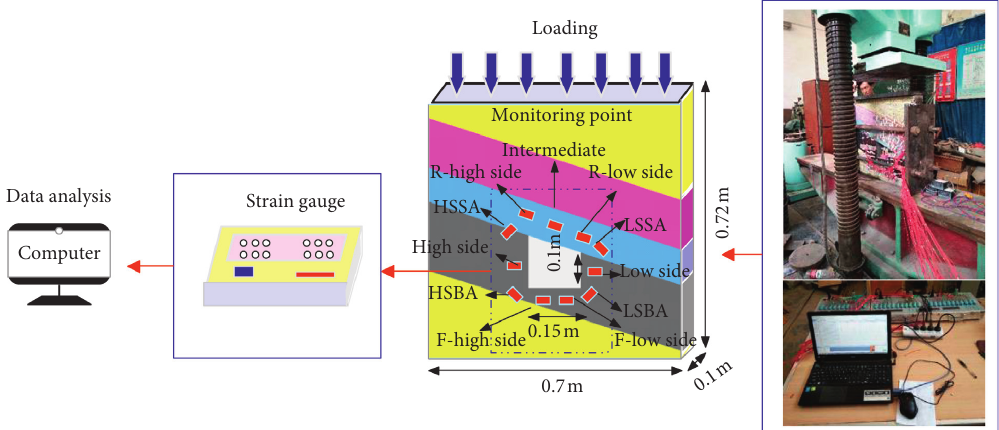
Figure 11: Test models of the right-angled trapezoidal roadway.